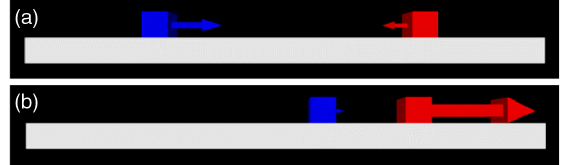
FIG. 5. Computational model of two cubes colliding (a) before and (b) after an elastic collision. The blue cube represents a semi truck and the red cube represents a red Ferrari, with arrows representing each object ’ s